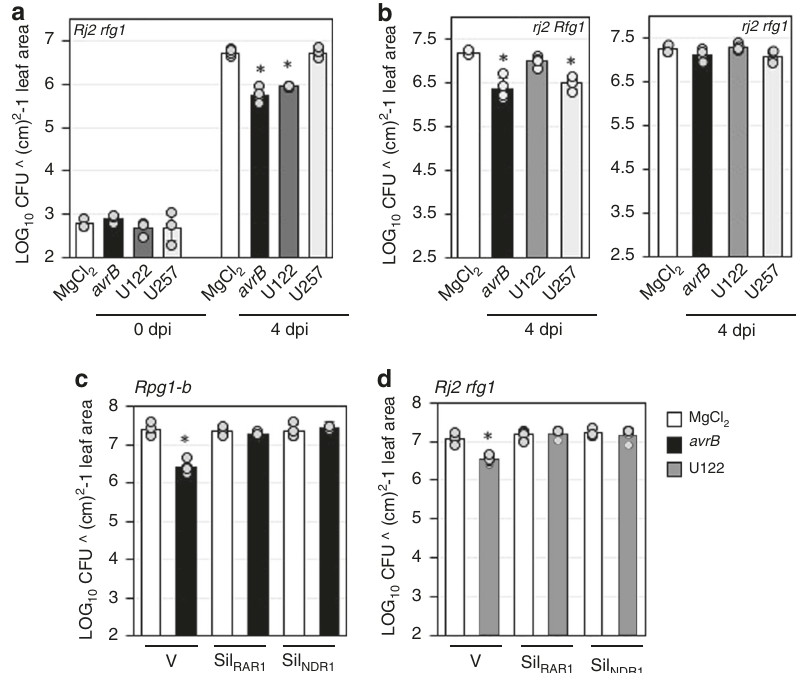
Fig. 2 Rj2 -derived rhizobia incompatibility induces systemic resistance in soybean. a – d Bacterial counts of Psg Vir in soybean plants that were pre-in fi ltrated (leaf) with buffer (MgCl 2 ) or Psg avrB ( avrB ), or pre-inoculated (root) with U122 or U257. LOG 10 values of colony forming units (CFU) ^ cm 2 -1 leaf area from infected leaves at 0 and 4 days post inoculation (dpi) are presented. Error bars indicate standard deviation ( n = 4). Asterisks denote signi fi cant difference from MgCl 2 in ( a ) and ( b ), and signi fi cant difference from MgCl 2 of same genotype in ( c ) and ( d ), Student ’ s t -test, P < 0.0002. a Wild-type plants of Rj2 rfg1 genotype were used. b Wild-type plants of rj2 Rfg1 or rj2 rfg1 genotype were used. c V (VIGS vector control), S RAR1 ( GmRAR1 knockdown) or S NDR1 ( GmNDR1 knockdown) plants of Rpg1-b genotype were used. d V, S RAR1 or S NDR1 plants of Rj2 rfg1 genotype were used. Results are representative of three-four independent